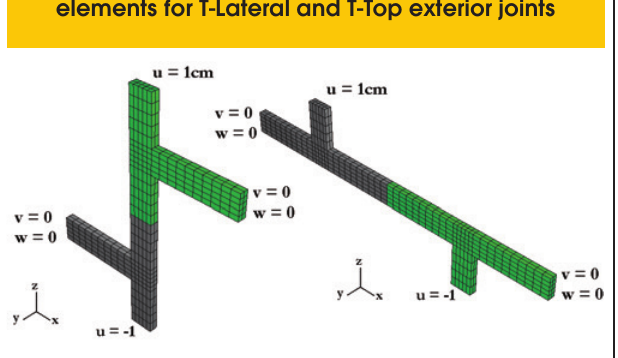
Figure 11 – Anti-symmetric model in finite elements for T-Lateral and T-Top exterior joints